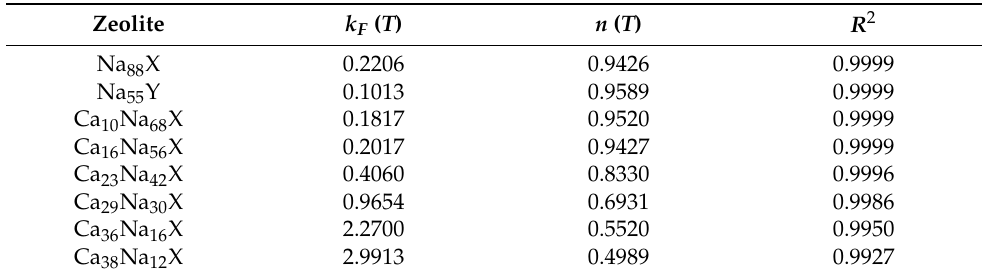
Table 1. Fitted Freundlich